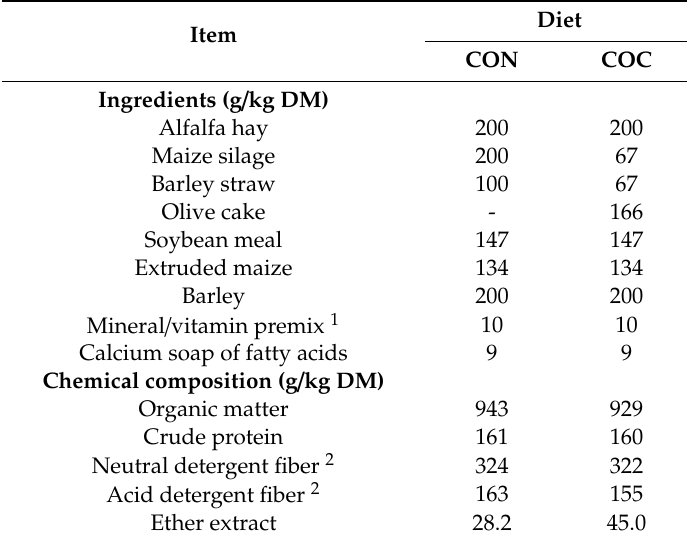
Table 1. Ingredients and chemical composition of the experimental diets used in the Rusitec fermenters. Item